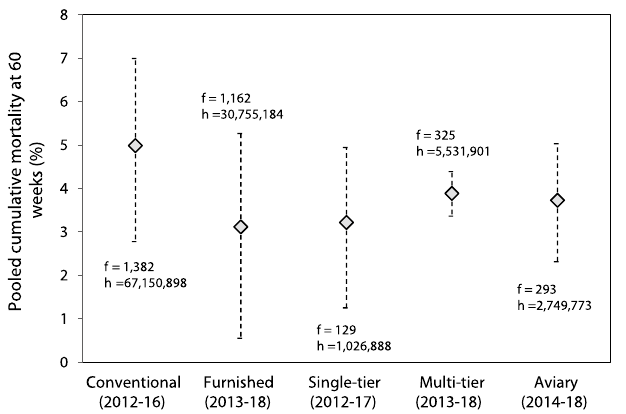
Figure 6. Pooled estimates of cumulative layer mortality in recent years. Pooled estimates of cumulative layer mortality at 60 weeks (95% CI) using the five most recent data sources for each commercially managed indoor housing system (conventional cages, furnished cages, single-tier aviaries, multi-tier aviaries and all types of aviaries). Years of data collection are shown below each housing system ( f : number of flocks; h = number of